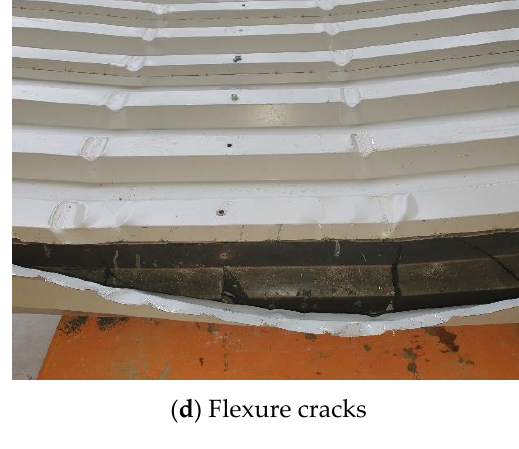
Figure 9. Failure mode of multi-cell panels.